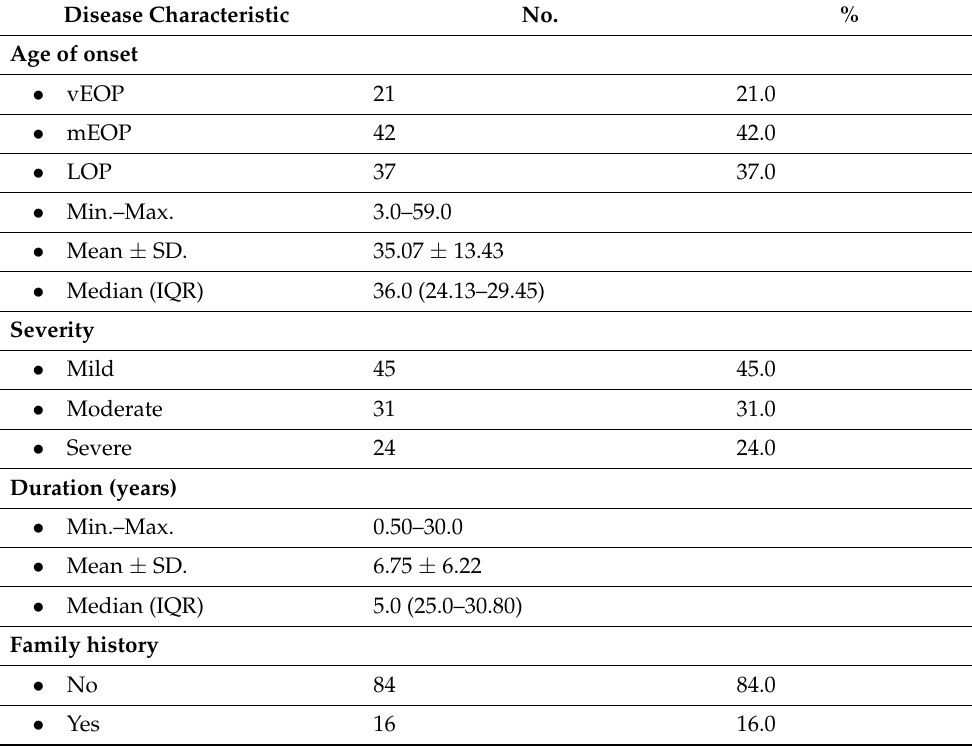
Table 2. Disease characteristics among psoriatic study population ( n =